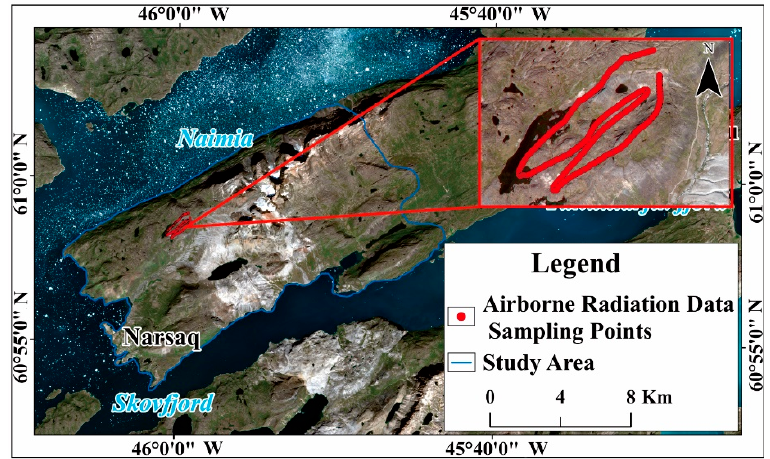
Figure 14. Map of sampling points for airborne radiation data.